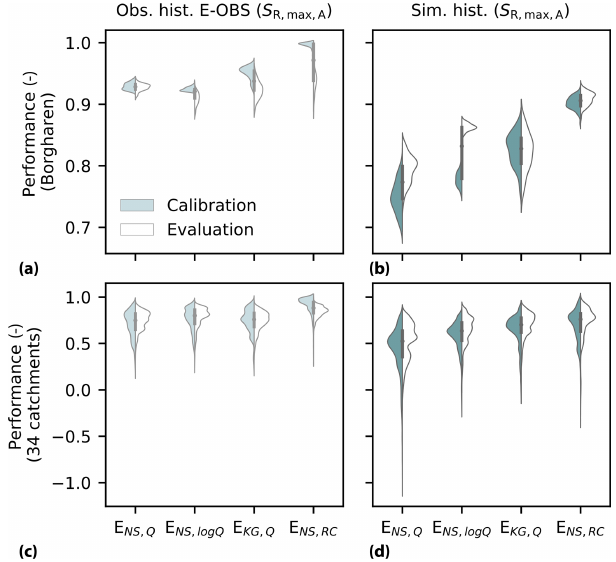
Figure 6. Streamflow model performance during calibration and evaluation for the four objective functions when the model is forced with ( a,c ) observed historical E-OBS data and ( b,d ) simulated his- torical climate data at ( a,b ) Borgharen and ( c,d ) for the ensemble of nested catchments in the Meuse basin. The four objective func- tions are the Nash–Sutcliffe efficiencies of streamflow, logarithm of streamflow and monthly runoff coefficient ( E NS , Q , E NS , logQ and E NS , RC ), as well as the Kling–Gupta efficiency of streamflow ( E KG , Q ). Note the different y -axis scales between